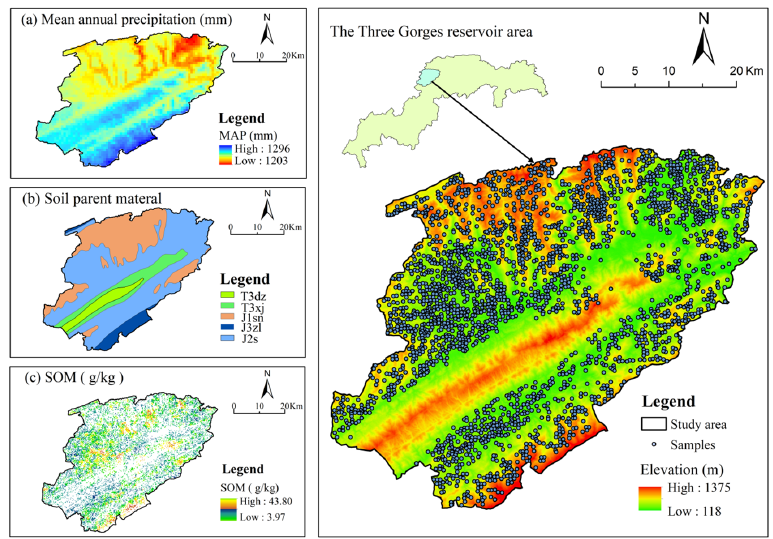
Figure 1. The sampling sites, mean annual precipitation ( a ), soil parent material ( b ), and soil organic matter (SOM) ( c ) distribution in Kaizhou, the Three Gorges reservoir area,